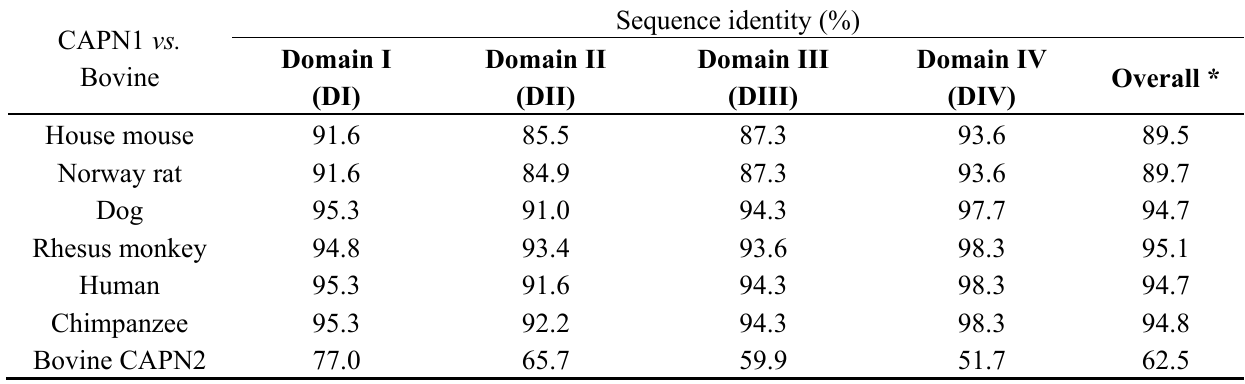
* Overall amino acid sequence identities (%) are shown, as are those for each domain for CAPN catalytic subunits. Bold letters indicate a compared to between two calpain isozymes (CAPN1 and CAPN2) from bovine through four